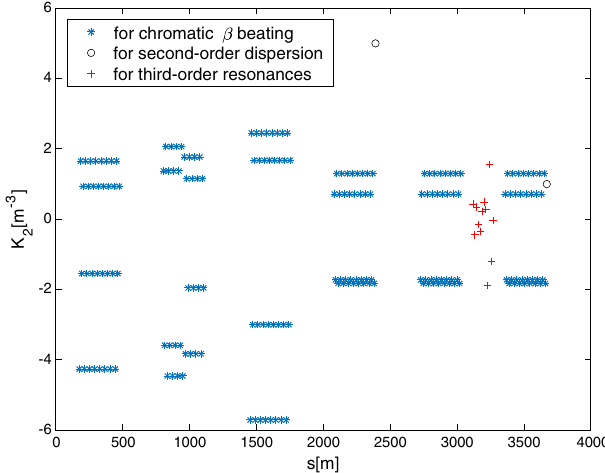
FIG. 12. Settings of all chromatic sextupoles (blue color) in the arcs and harmonic sextupoles (red color) in the dispersion-free straight.